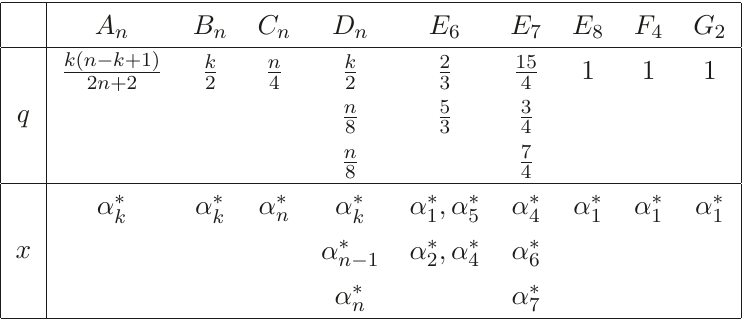
1, 1 k n for A n ≥ ≤ ≤